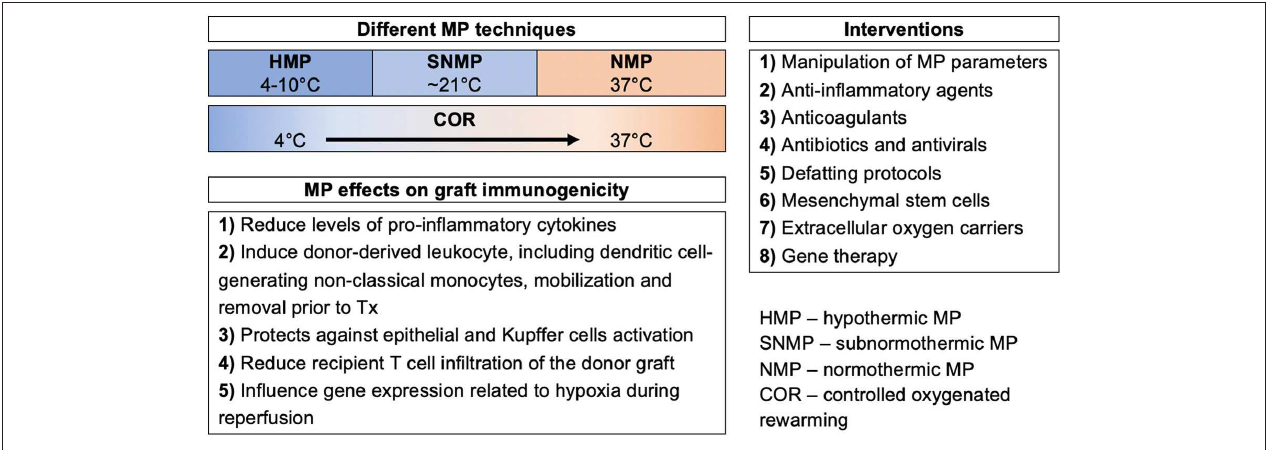
FIGURE 2 | Different machine perfusion strategies of extended criteria donor organs for protection against activation of innate